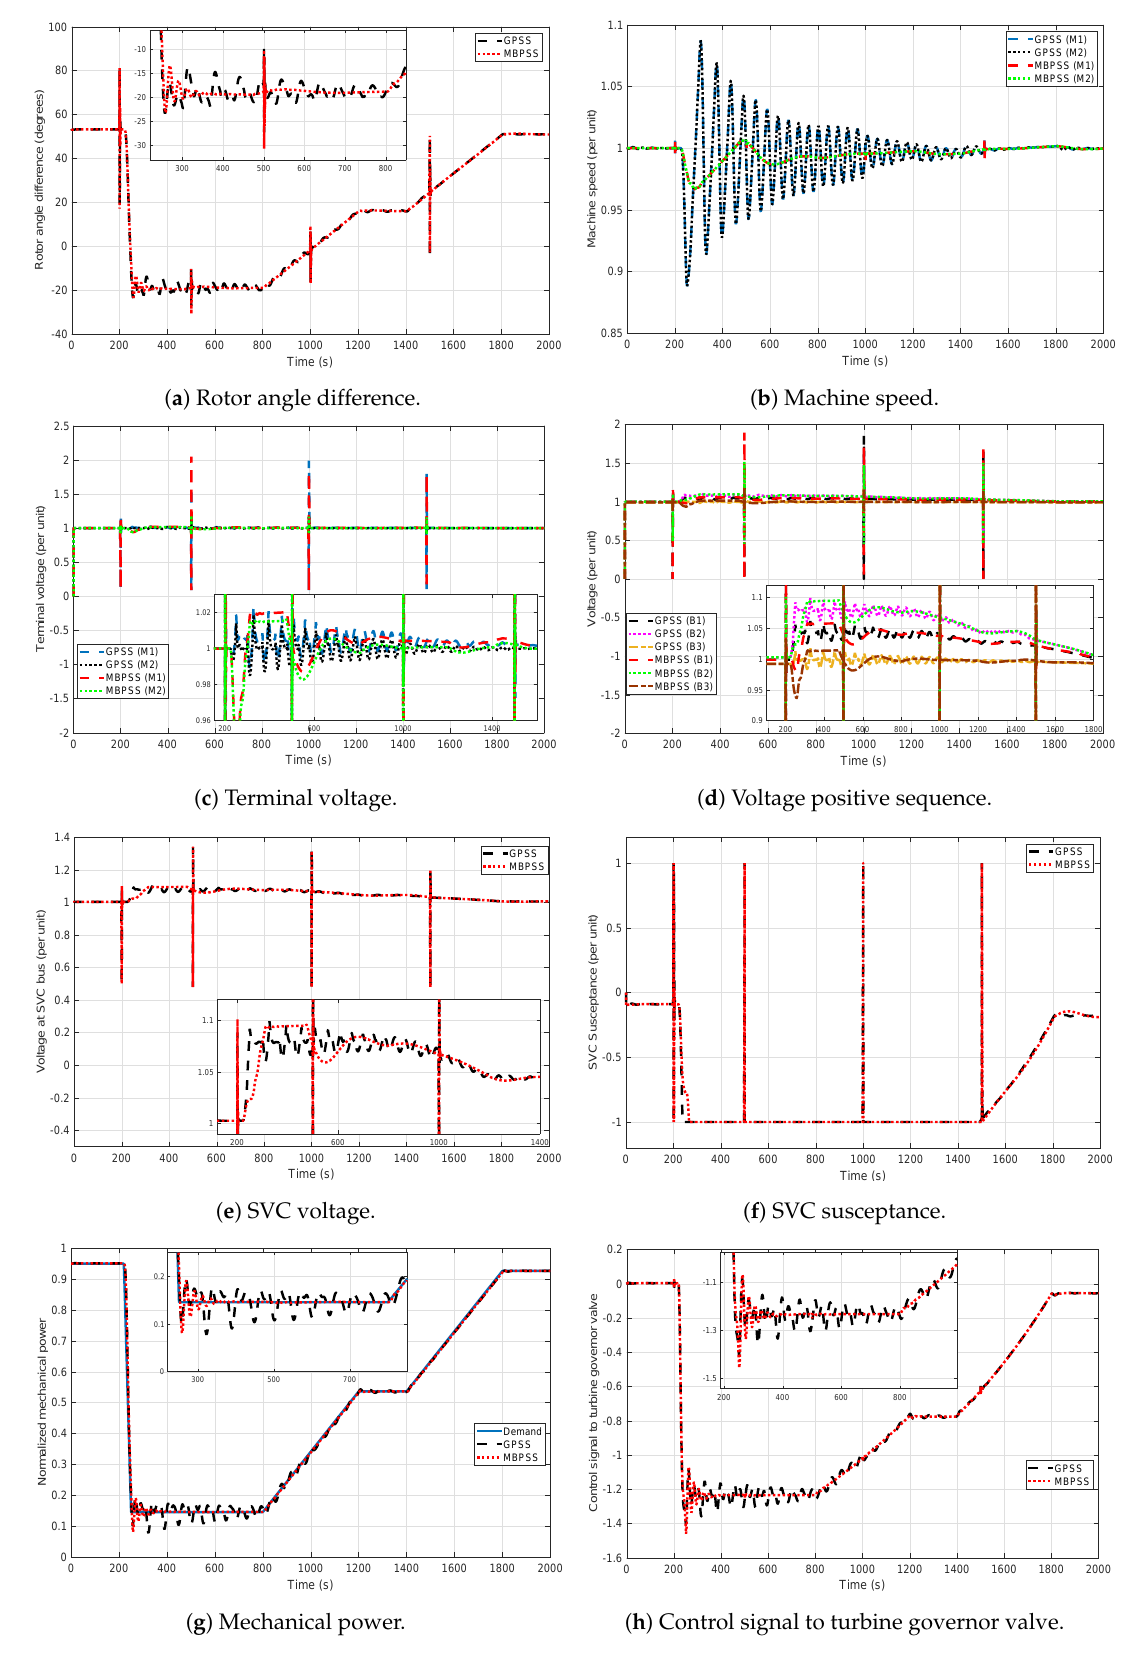
Figure 10. Case II.1: Variation in network signals during three-phase faults with generic and multiband PSS with a static var compensator